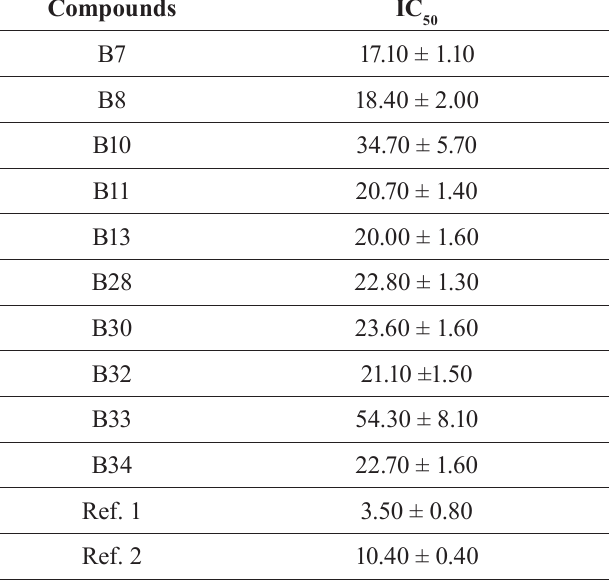
TABLE IV - Antioxidant activity of the compounds (µg/mL)